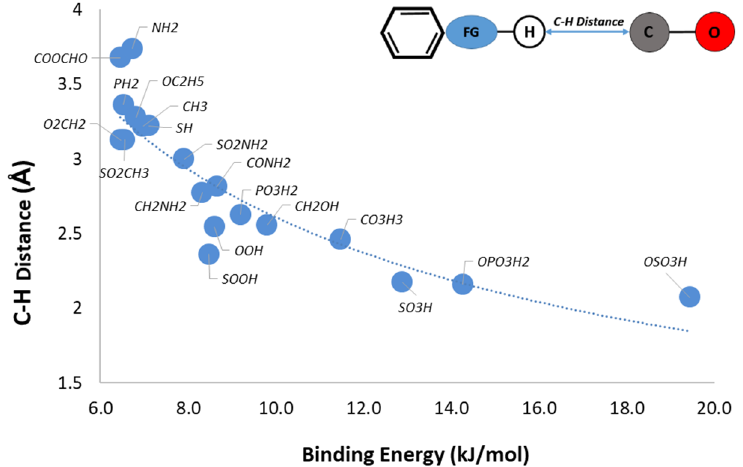
Figure 3. Plot of the distance between the Carbon atom of the CO molecule and the Hydrogen atom of the functional group as a function of the binding energy.